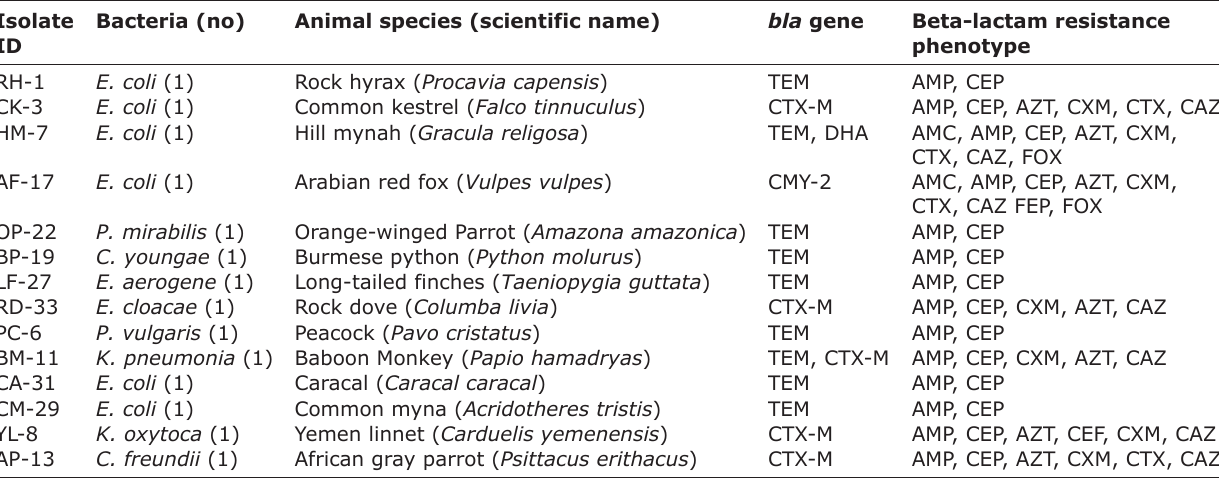
Table-3: Genotypic characteristics and occurrence of β -lactamases encoding genes in enterobacteria from wild pet